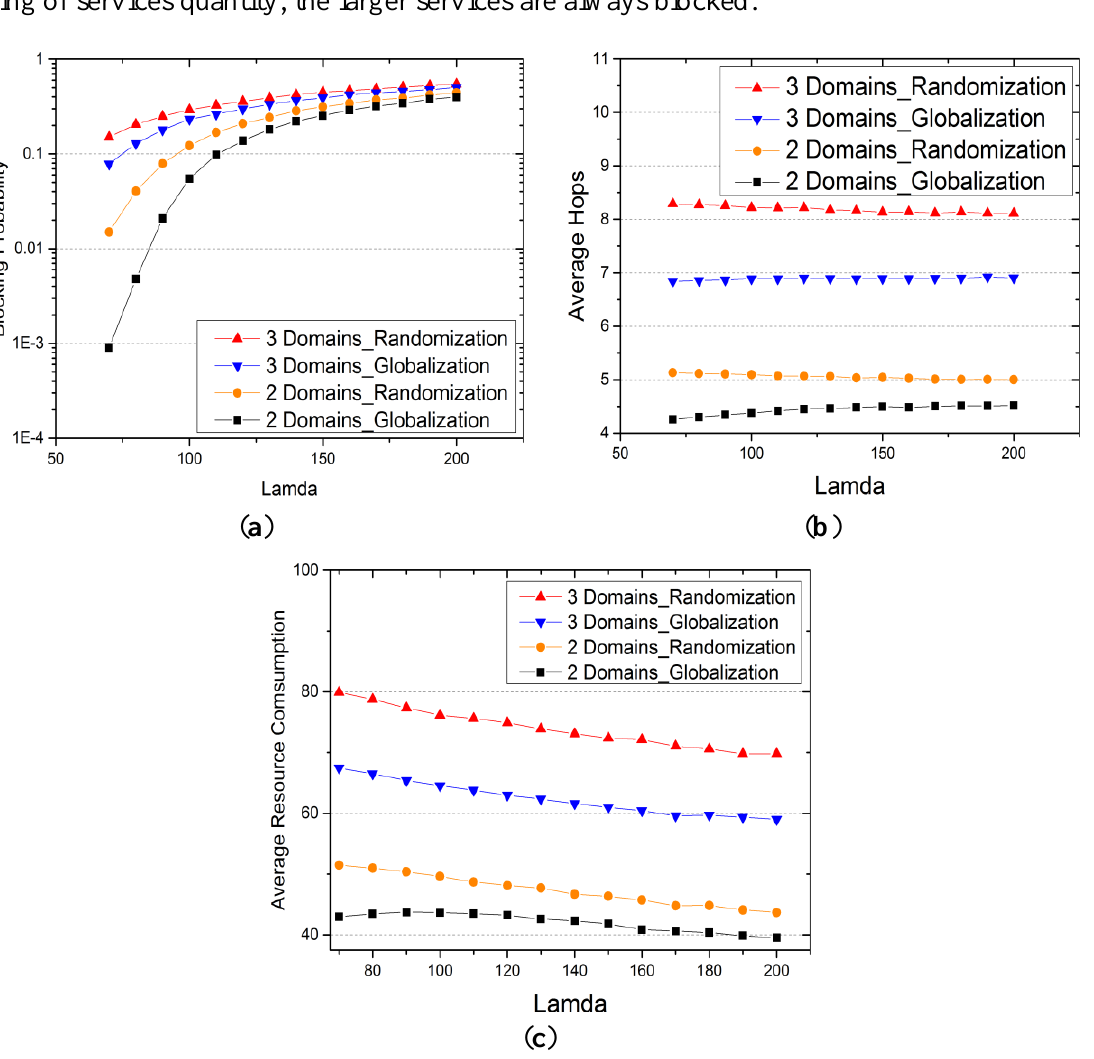
Figure 4. ( a ) Blocking probability; ( b ) average hops; ( c ) average resource consumption among various strategies under heavy traffic load